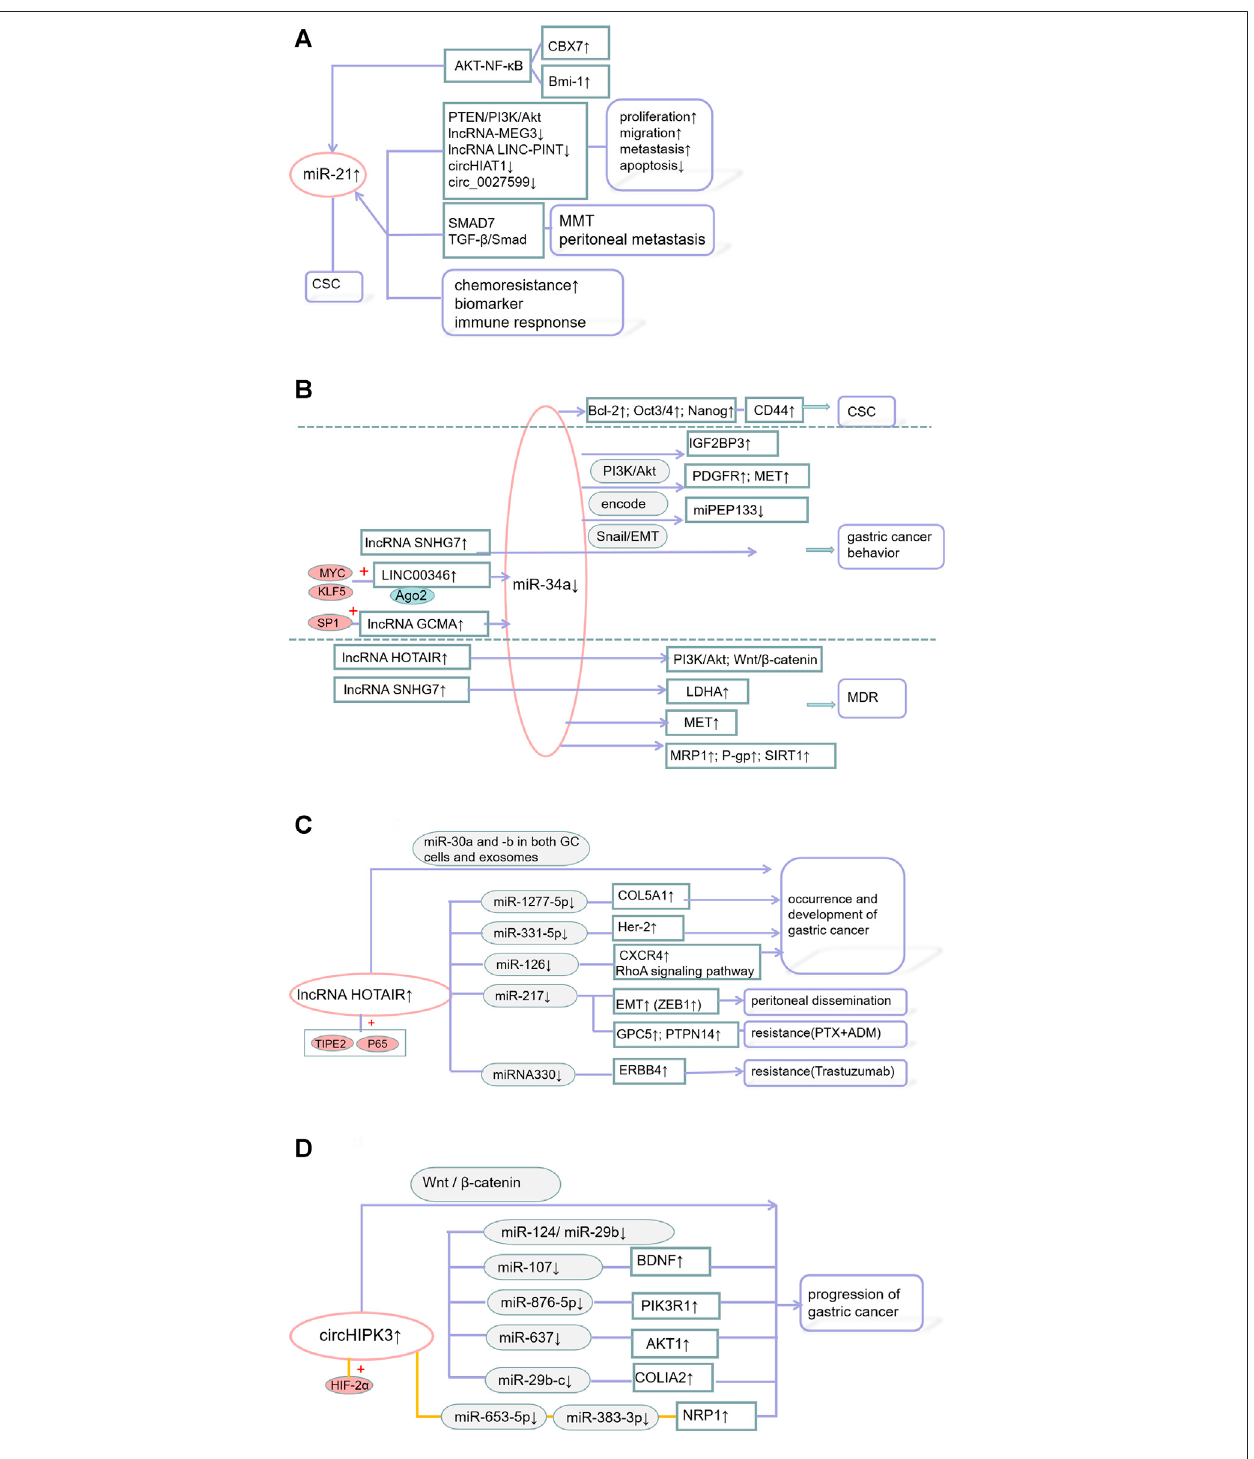
FIGURE 3 | (A) The mechanism of miR-21 in GC; (B) The mechanism of miR-34a in GC; (C) The mechanism of lncRNA HOTAIR in GC; (D) The mechanism of circular RNA circHIPK3 in GC.